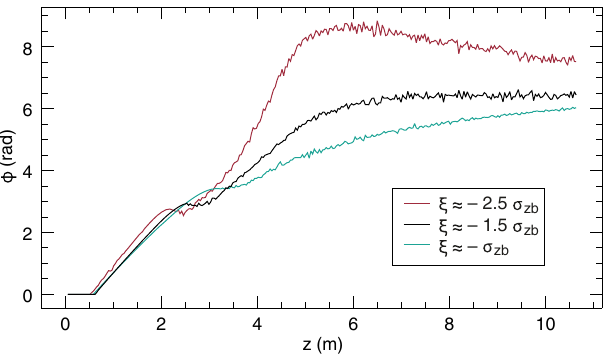
FIG. 6. Evolution of the local phase shift of the wakefields with respect to the seed for three different positions along the proton bunch.